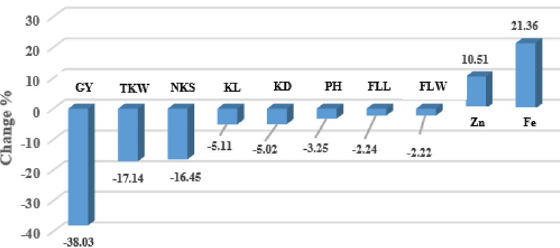
Figure 1. Percent change of each trait due to water stress relative to normal irrigation conditions. GY, Grain yield (g/m 2 ); NKS, Number of kernel per spike; TKW, Thousand kernel weight (g); KL, Kernel length (mm); KD, Kernel diameter (mm); PH, Plant height (cm); FLL, Flag leaf length (mm); FLW, Flag leaf width (mm); Zn, Grain zinc content (µg/g); Fe, Grain iron content (µg/g).